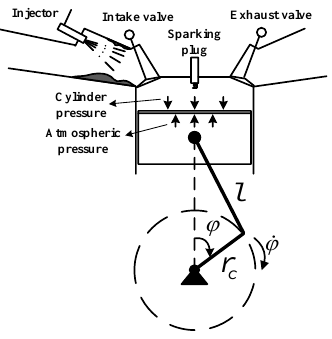
Figure 2. Schematic diagram of a single cylinder engine.